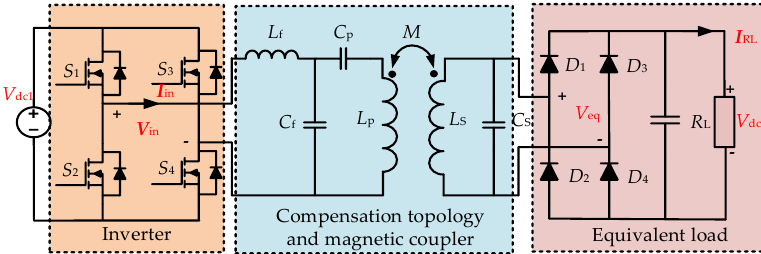
Figure 1. The circuit topology with LCC-P compensation.